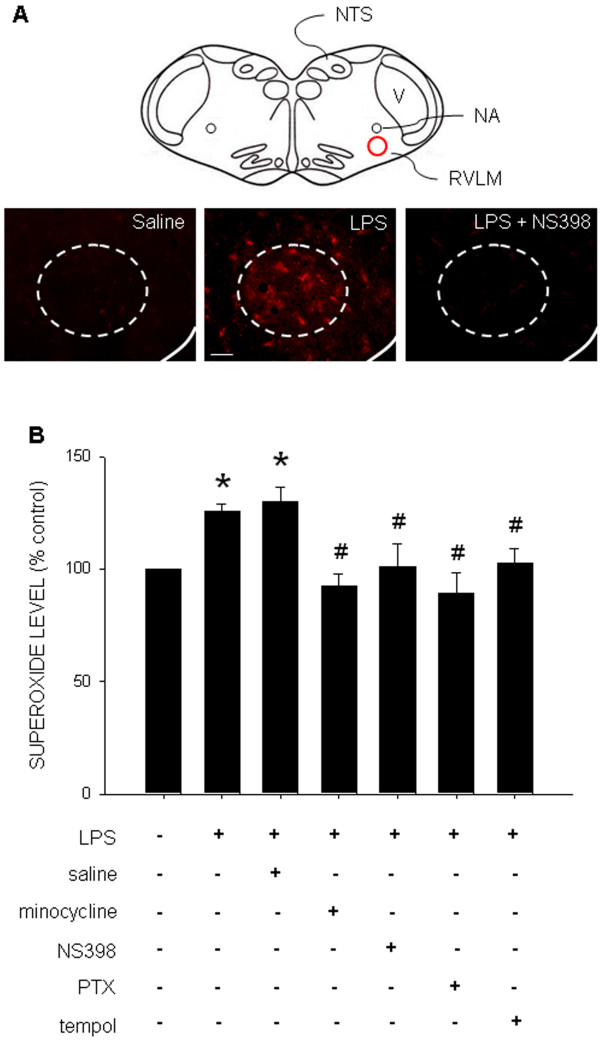
Intraperitoneal infusion of LPS induces neuroinflammation-associated oxidative stress in RVLM. Representative photomicrographs showing the distribution of dihydroethidium (red fluorescence) (A), or changes in tissue level of superoxide (B) in RVLM examined on day 7 after intraperitoneal infusion of saline or LPS (1.2 mg/kg/day), alone or with additional intracisternal infusion of minocycline (9 nmol/μL/h), pentoxifylline (PTX, 30 nmol/μL/h), NS398 (1.5 nmol/μL/h), or tempol (1 μmol/μL/h). Values are mean ± SEM (n=8 to 10 animals in each experimental group). *P <0.05 vs. saline-treatment group; #P <0.05 vs. LPS-treatment group in the post hoc Scheffé multiple-range test. A schematic drawing of rostral medulla oblongata is included in (A) to illustrate the location of RVLM from where the photomicrographs were taken. NA, nucleus ambiguous; NTS, nucleus tractus solitarii; V, nucleus spinalis trigemini. Scale bar in (A): 100 μm.